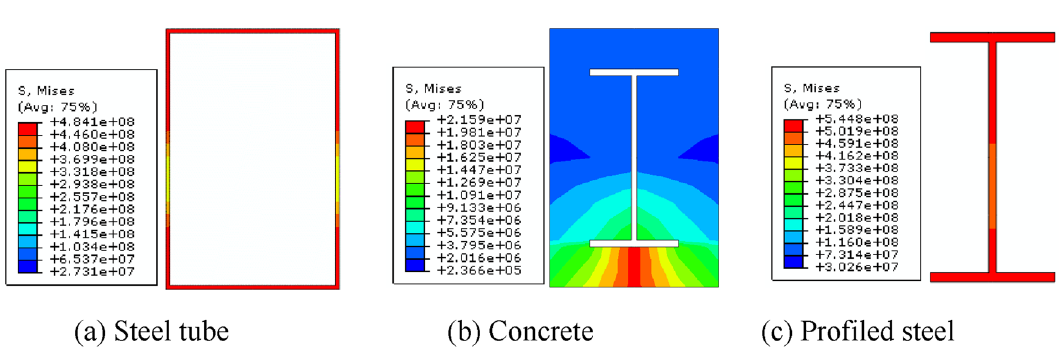
Figure 13. Stress cloud in the span section of SRCFST column after fire on three